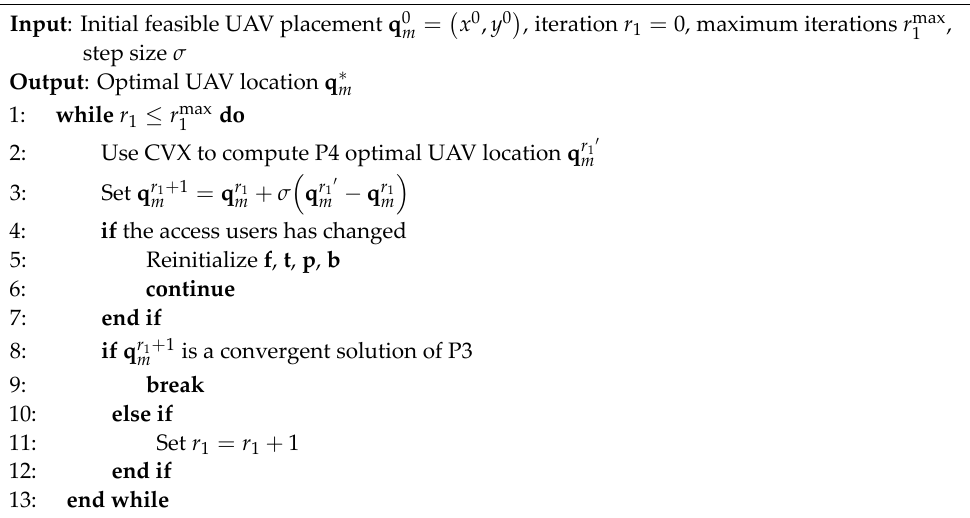
Algorithm 1: UAV Placement Optimization